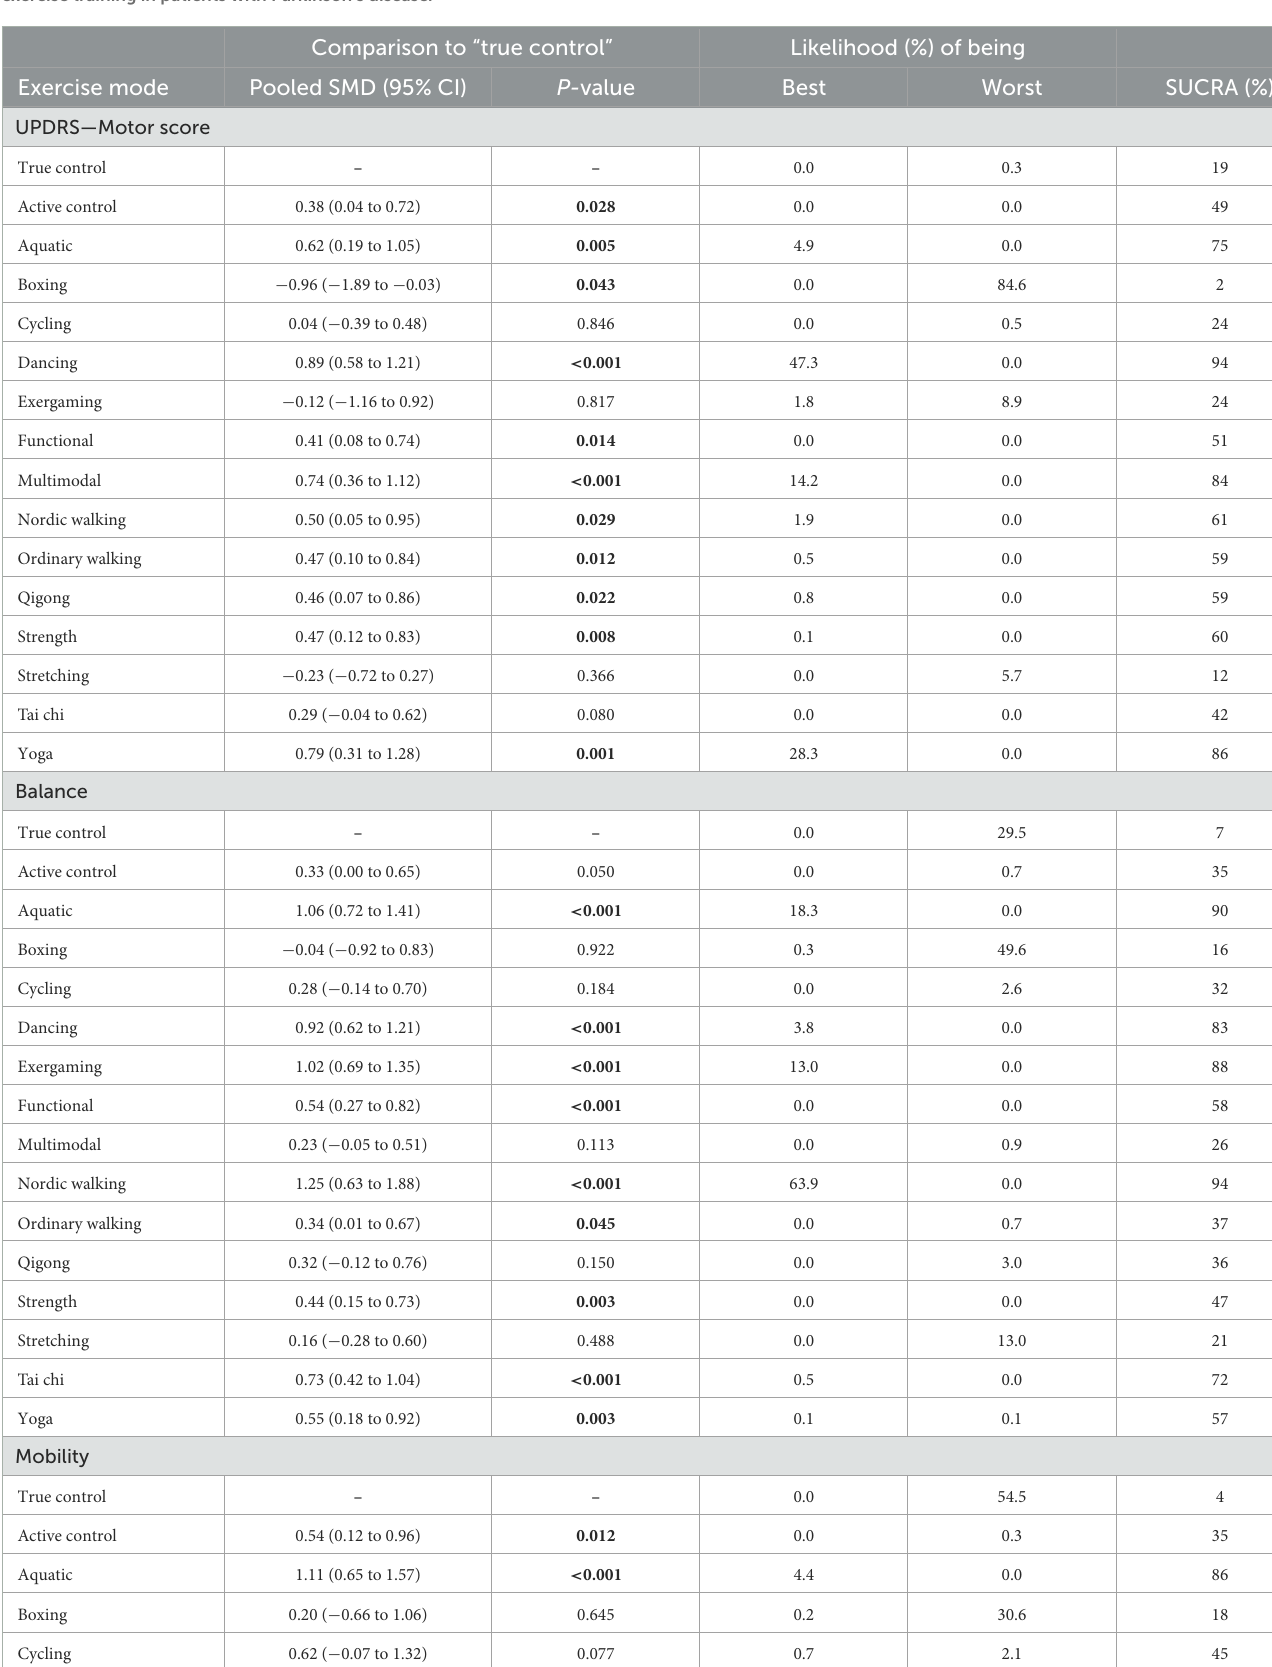
TABLE 2 Network meta-analysis consistency models for UPDRS-motor score, balance, mobility, and manual dexterity in studies examining the efficacy of exercise training in patients with Parkinson’s disease. Comparison to “true